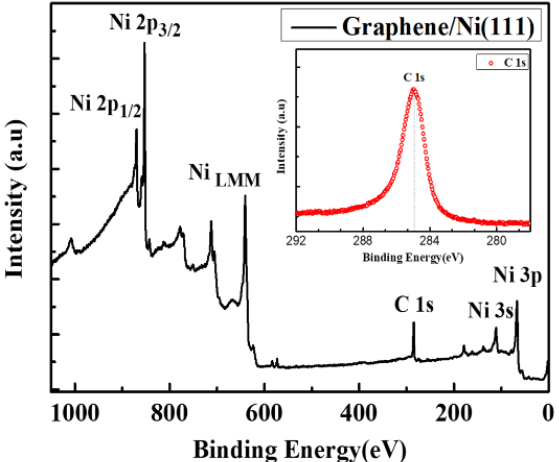
Figure 6. XPS spectra of the graphene/Ni (111) interface. The inset shows the C 1s peak of the gra- phene at 285.0